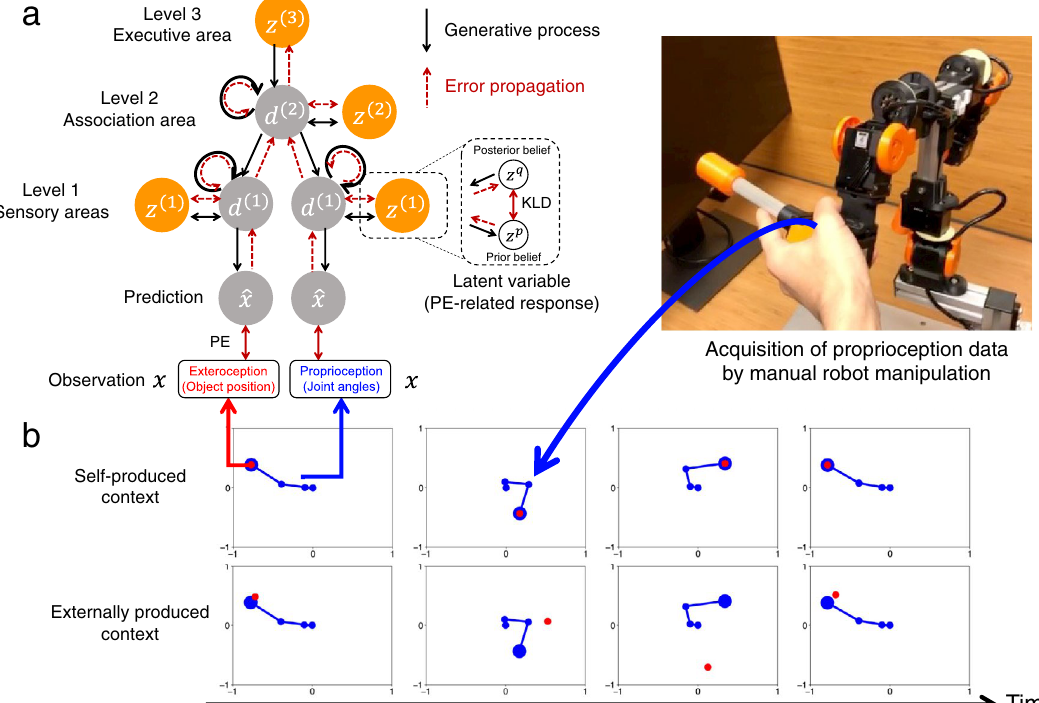
Figure 1. Training setting. ( a ) Hierarchical recurrent network updating of synaptic weights and posterior beliefs in all areas via minimization of free-energy determined by the prediction error (PE) and Kullback-Leibler divergence (KLD) between the posterior and the prior. ( b ) Spontaneous sensorimotor patterns learned by the recurrent